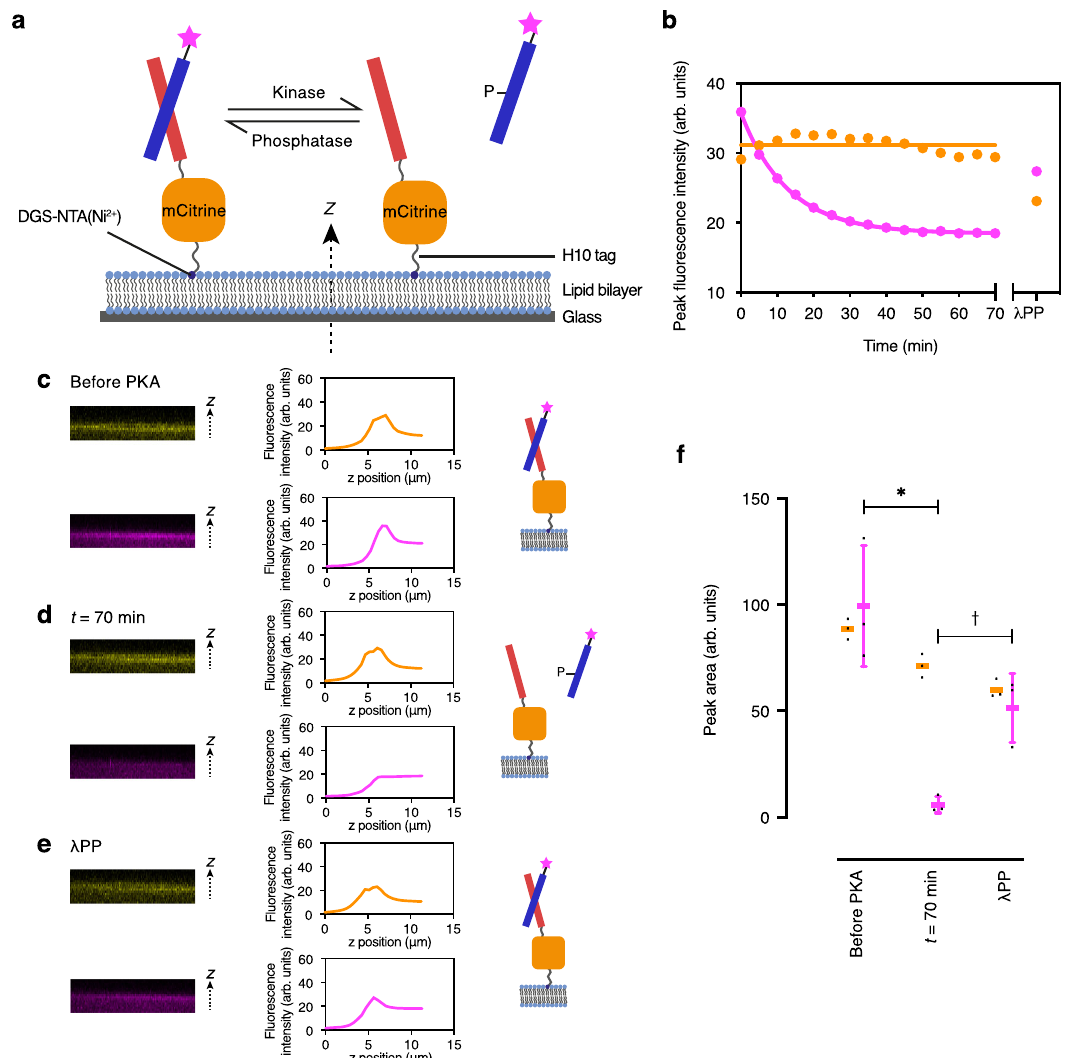
Fig. 3 Reversible membrane tethering of a cargo peptide to an anchor protein. a Illustration of reversible membrane tethering on Supported Lipid Bilayers (SLBs) with CC-Di-A_S in red, CC-Di-B_RRS in blue, and Alexa Fluor 594 (AF594) in pink. b Representative kinetics of phosphorylation-induced release of the cargo peptide (AF594-CC-Di-B_RRS, pink line) from the anchor protein (CC-Di-A_S-mCitrine-H10, orange line). Phosphorylation was initiated with PKA (cAMP-dependent protein kinase) and MgATP and reversed by lambda protein phosphatase ( λ PP) and MnCl 2 . Experiments were performed in triplicate. Plotted fl uorescence intensities (arbitrary units) are peak intensities (i.e., membrane localized), determined from z-axis fl uorescence intensity pro fi les such as those shown in c – e . Values corresponding to the cargo peptide were fi tted with the function y ¼ y anchor protein were fi tted with the function y = k . Representative xz plane confocal images from z-stacks are shown together with fl uorescence z-pro fi les and illustrative schematics for: c CC-Di-A_S-mCitrine-H10 and AF594-CC-Di-B_RRS on an SLB; d the system of c 70 min after the addition of PKA; e the system of d after adding λ PP. f Quantitation of membrane binding of CC-Di-A_S-Citrine-H10 (orange) and AF594-CC-Di-B_RRS (pink) under the conditions of c – e , calculated from fl uorescence z-pro fi les ( n = 3 independent experiments; error bars represent mean ± S.D.; * p = 0.005, t = 5.6127; † p = 0.009, t = 4.7414; unpaired two-tailed t test). SLBs were DOPC with 2 mol% DGS-NTA(Ni 2 + ) and 0.1 mol% ATTO655-DOPE. AF594-CC-Di-B_RRS and CC-Di-A_S-mCitrine-H10 were both at 1 µ M. The SLB buffer was 50 mM Tris.HCl, pH 7.5, 300 mM KCl, and 5 mM MgCl 2